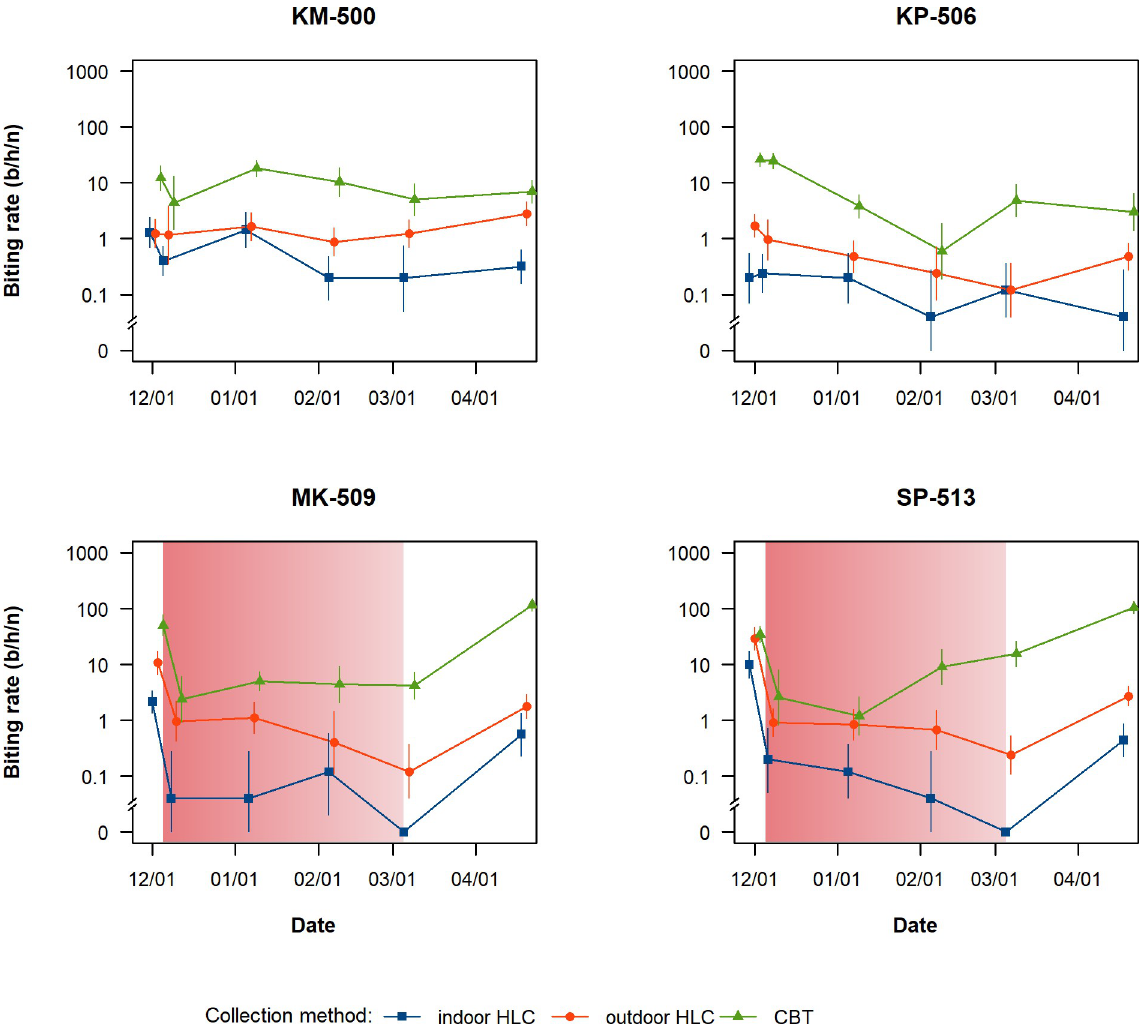
Fig 3. Impact of ORS on malaria vector biting rates. ORS intervention was carried out on 3 rd and 4 th December 2016 in MK-509 and on 5 th and 6 th December 2016 in SP-513. Gradient-filled panels show previous estimate of the longevity of the residual insecticidal effects of lambda- cyhalothrin mist applied to outdoor vegetation (98 days) [32]. Error bars indicate the negative binomial regression 95% confidence intervals. Abbreviations : b/h/n: bites /host /night; CI, confidence interval; HBR, human-biting rate; ORS, outdoor residual spraying.